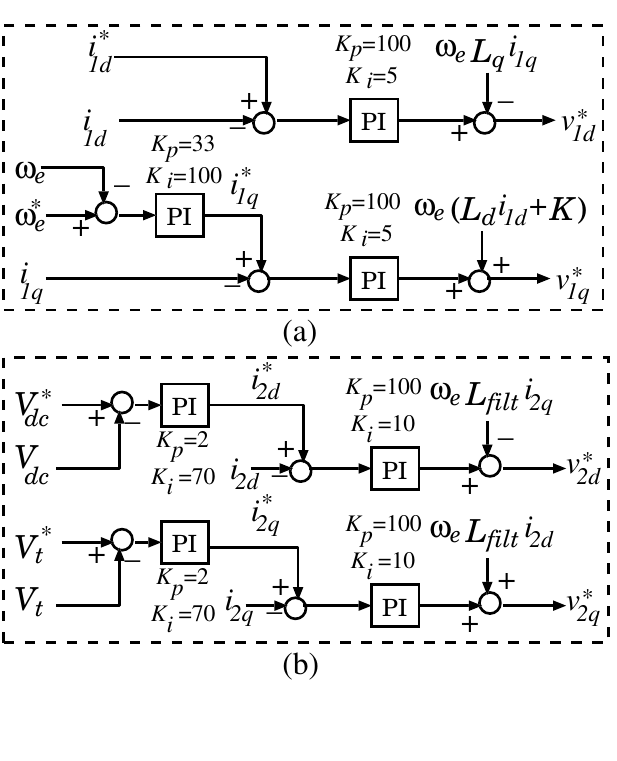
Figure 6. ( a ) Generator-side converter control system; ( b ) Grid-side inverter control